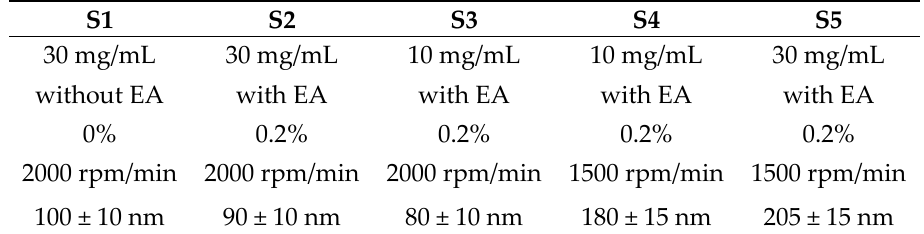
Table 1. Five sensitive layers with resulting thickness based on ZnO NPs in solutions at 10 or 30 mg/mL in isopropanol, with or without EA.